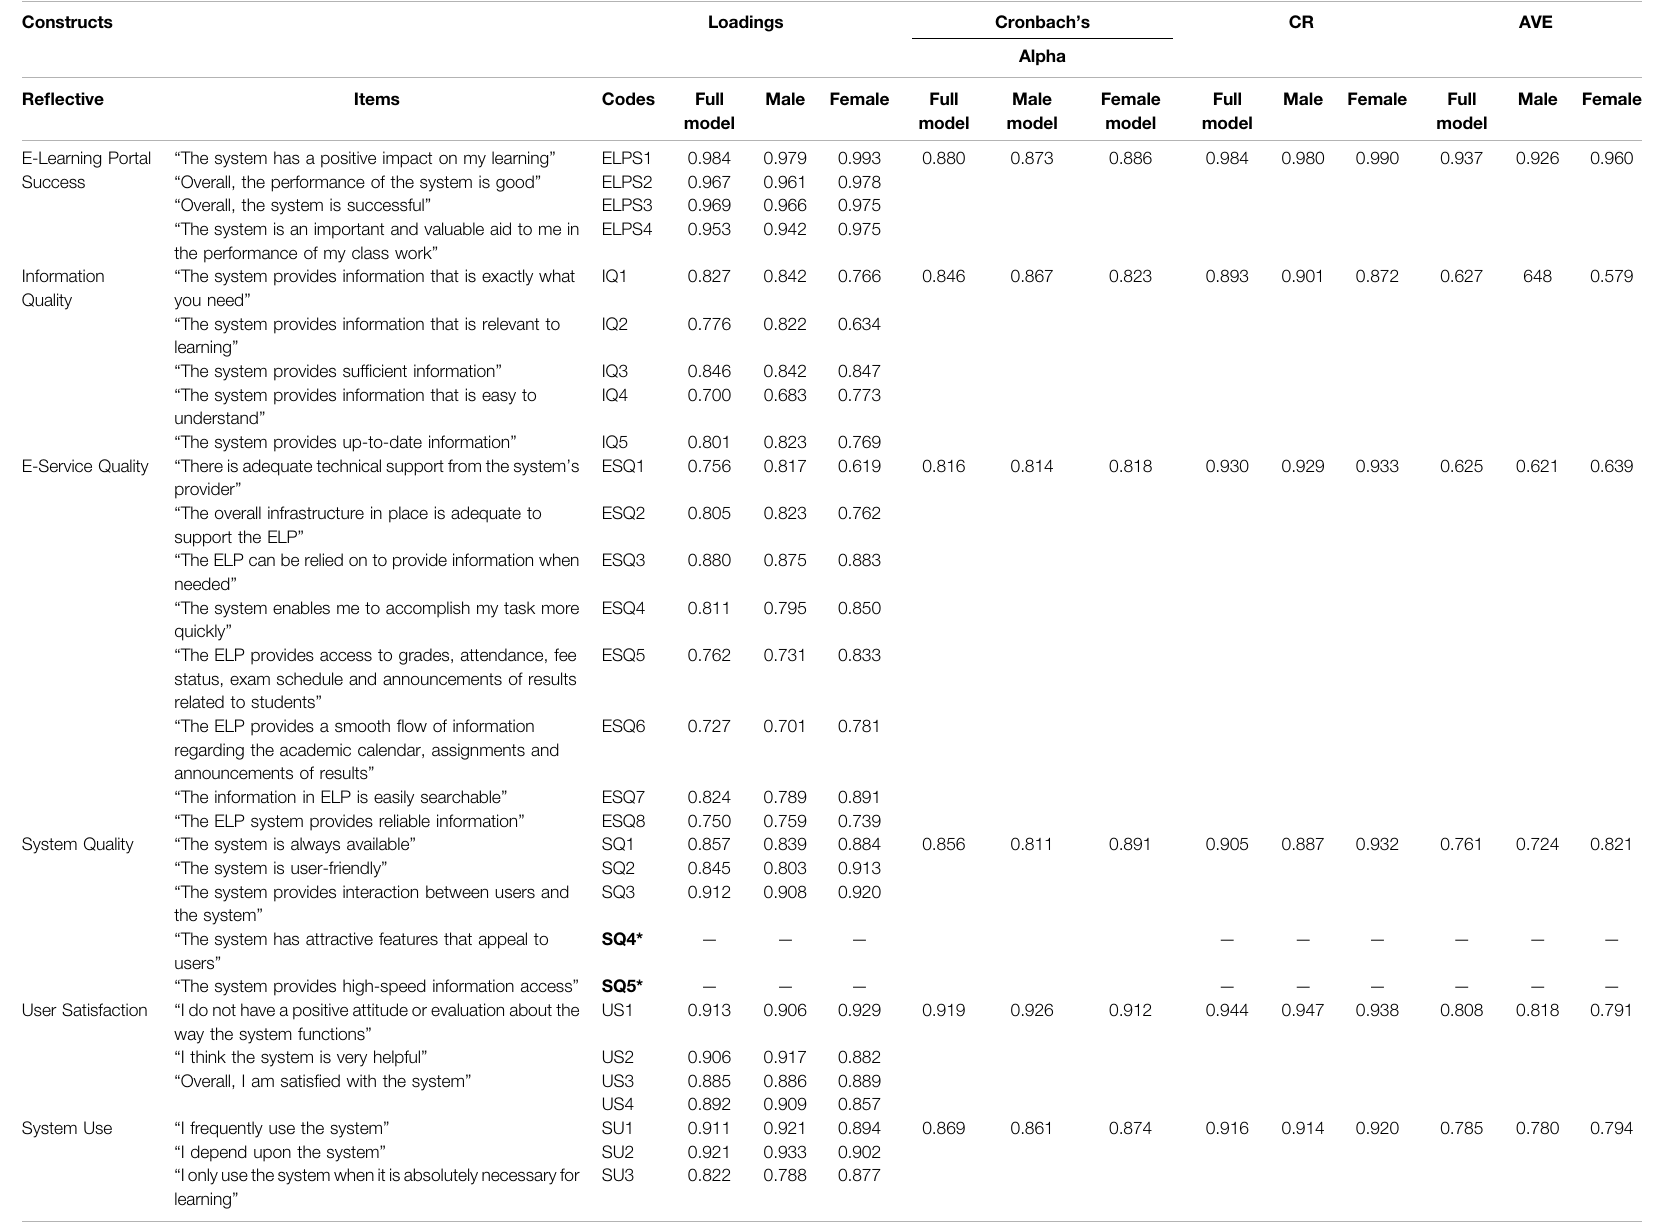
TABLE 4 | Assessment results for the measurement